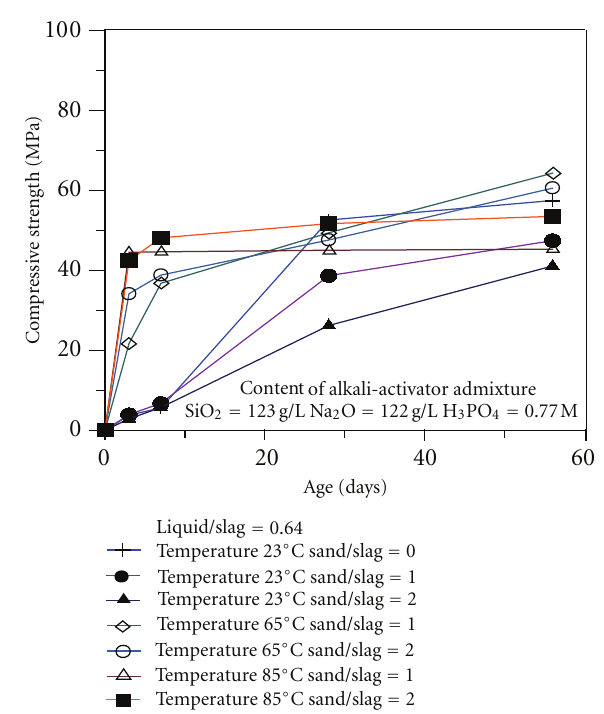
Figure 3: Compressive strength of AAS mortars ( L/S = 0 .